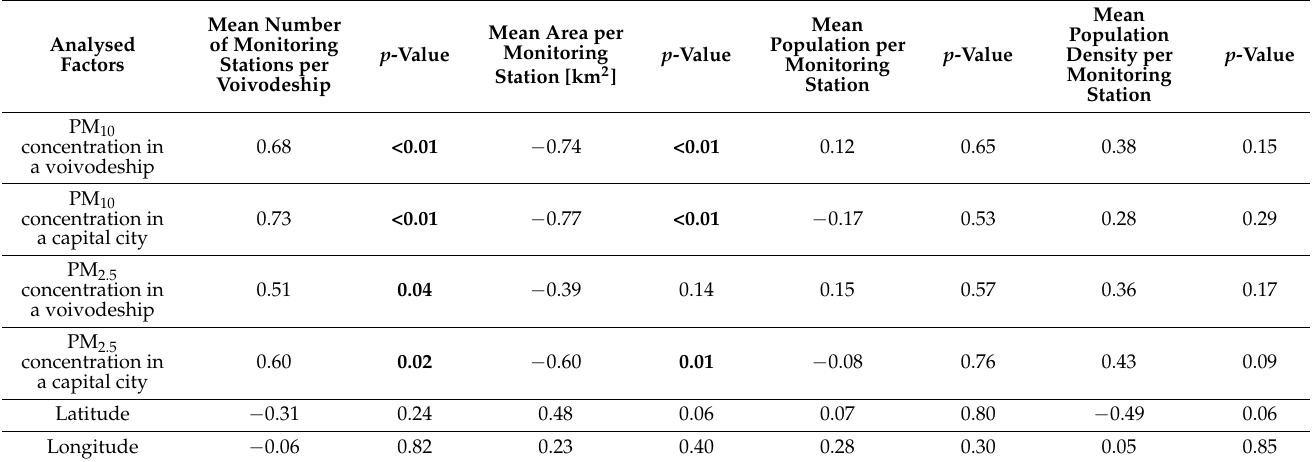
Table 5. Pearson product-moment correlation coefficients for correlations between aerial distribution of monitoring stations and corresponding